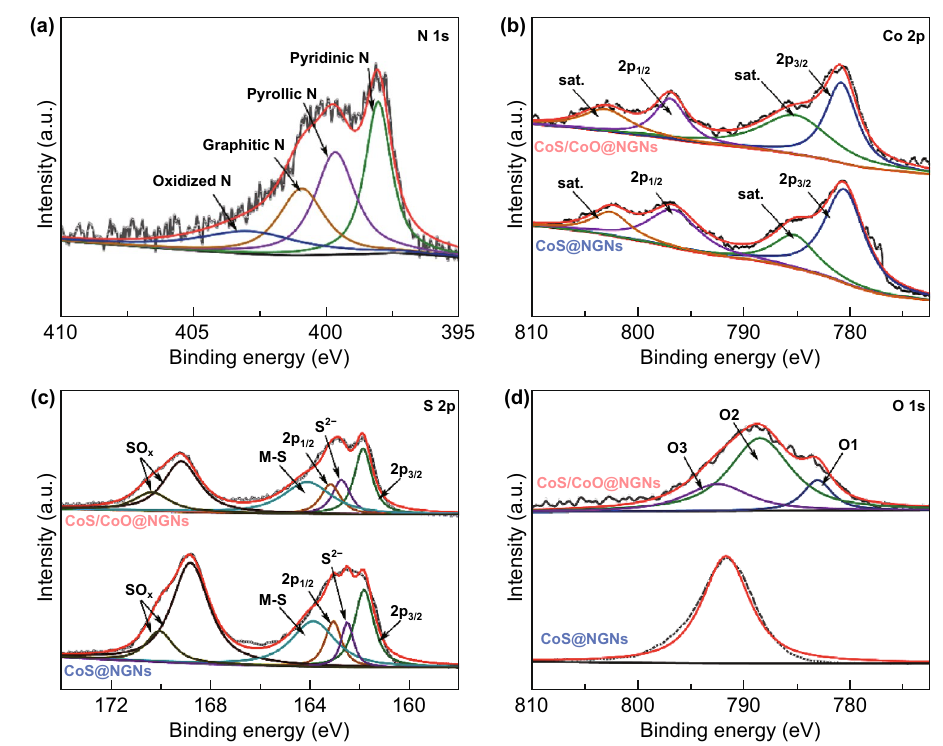
Fig. 3 a N 1 s XPS spectrum of CoS/CoO@NGNs. b Co 2p, c S 2p and d O 1 s XPS spectra of CoS@NGNs and